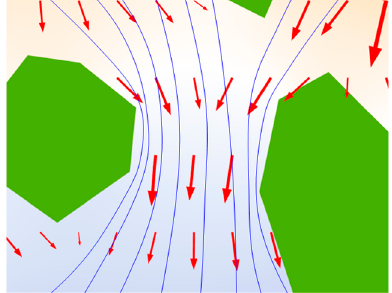
Figure 9. Local chloride ion diffusion.